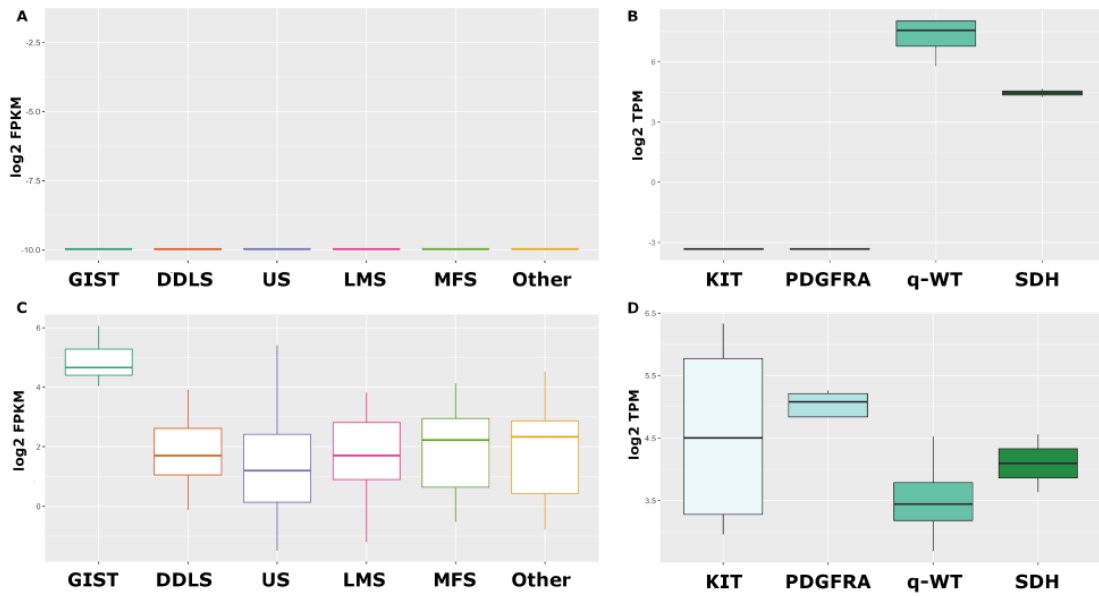
Figure 3. In silico analysis of FGFR ligands relevant in GIST pathogenesis. Expression of FGF4 in various subtypes of sarcomas ( A ) and in different molecular classes of GISTs ( B ). FGF2 expression in sarcomas ( C ) and in GIST samples ( D ). RNA sequencing data were taken from the CinSARC study on the GEO repository [55] and from Pantaleo et al. [22]. DDLS, Dedifferentiated Liposarcoma; US, Undifferentiated Sarcoma; LMS, Leiomyosarcoma; MFS, Myxofibrosarcoma. KIT, KIT-mutant GIST; PDGFRA, PDGFRA-mutant GIST; q-WT, quadruple WT; SDH, SDH- deficient . FPKM, Fragments Per Kilobase Million; TPM, Transcripts Per Kilobase Million.